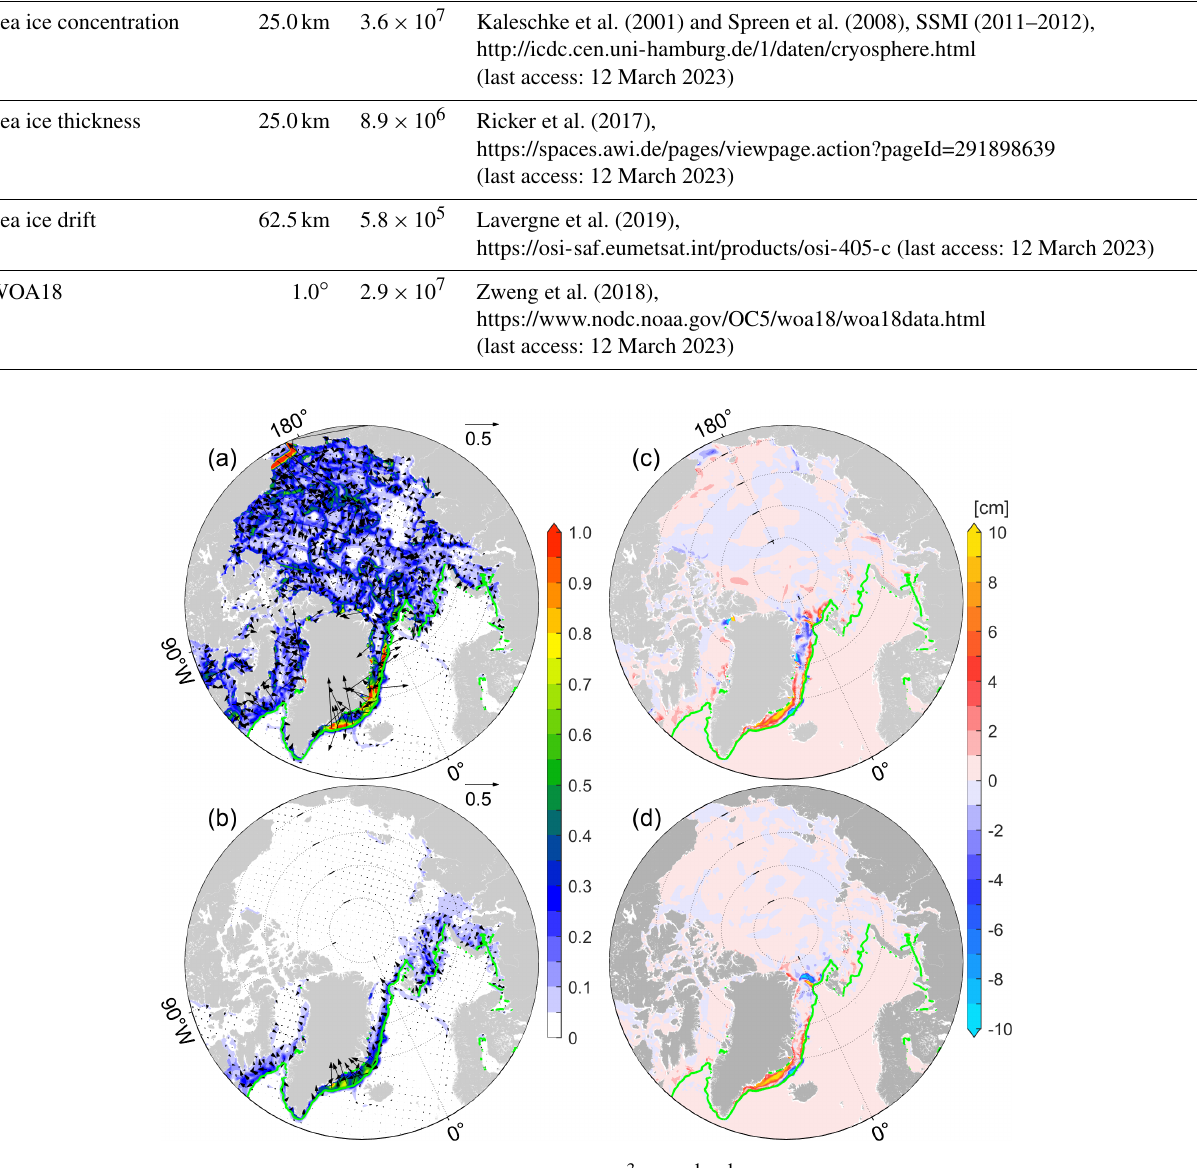
Figure 2. Sensitivities of total sea ice volume to wind vectors (in 0 . 1 × km 3 (ms − 1 ) − 1 , shadings represents amplitudes) using the adjoint of (a) free-drift sea ice dynamics and (b) viscous-plastic sea ice dynamics with modifications in Sect. 2.3. Panels (c) – (d) show the mean SIT changes by perturbing the wind with the corresponding adjoint sensitivities multiplied by a factor of 10 − 8 . The green lines are the sea ice extents (SIEs, 15% SIC) in January